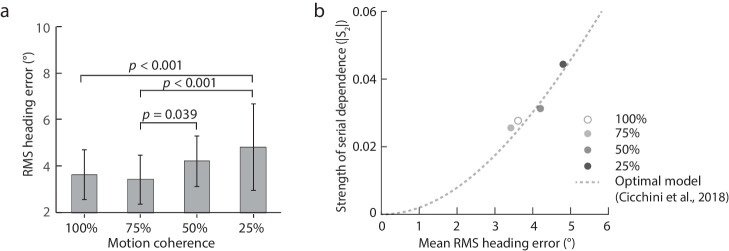

Experiment 2 data. (a) Mean RMS heading error averaged across participants against motion coherence. Error bars indicate ± 1 SD across 20 participants. (b) Strength of the repulsive serial dependence effect against the mean RMS heading error for the four motion coherence levels in optic flow. The dotted line indicates the predictions of the ideal observer (optimal) model (i.e. Equation 3.7 in Cicchini, Mikellidou, & Burr, 2018, with d = 22.3 degrees, the average distance between all relative headings, σ = mean RMS error). The model has no free parameters and captures well the relationship between the repulsive serial dependence effect and the mean RMS heading error (R2 = 0.90, p < 0.001).